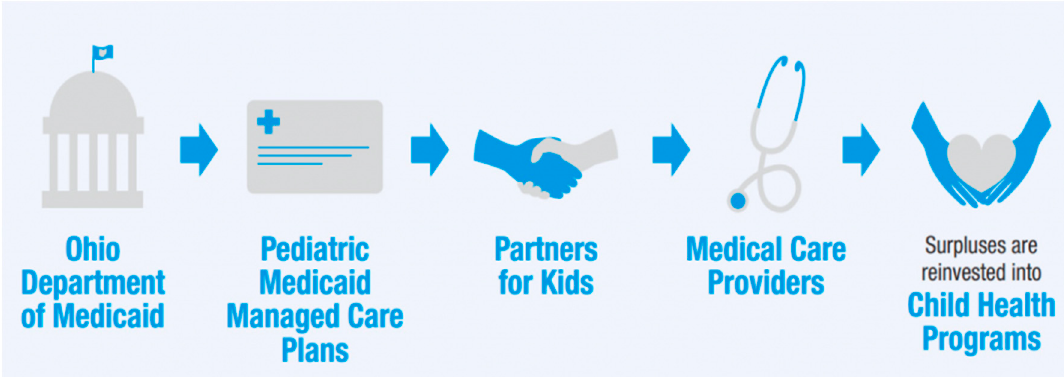
Figure 3. Partners for Kids flow of funds.